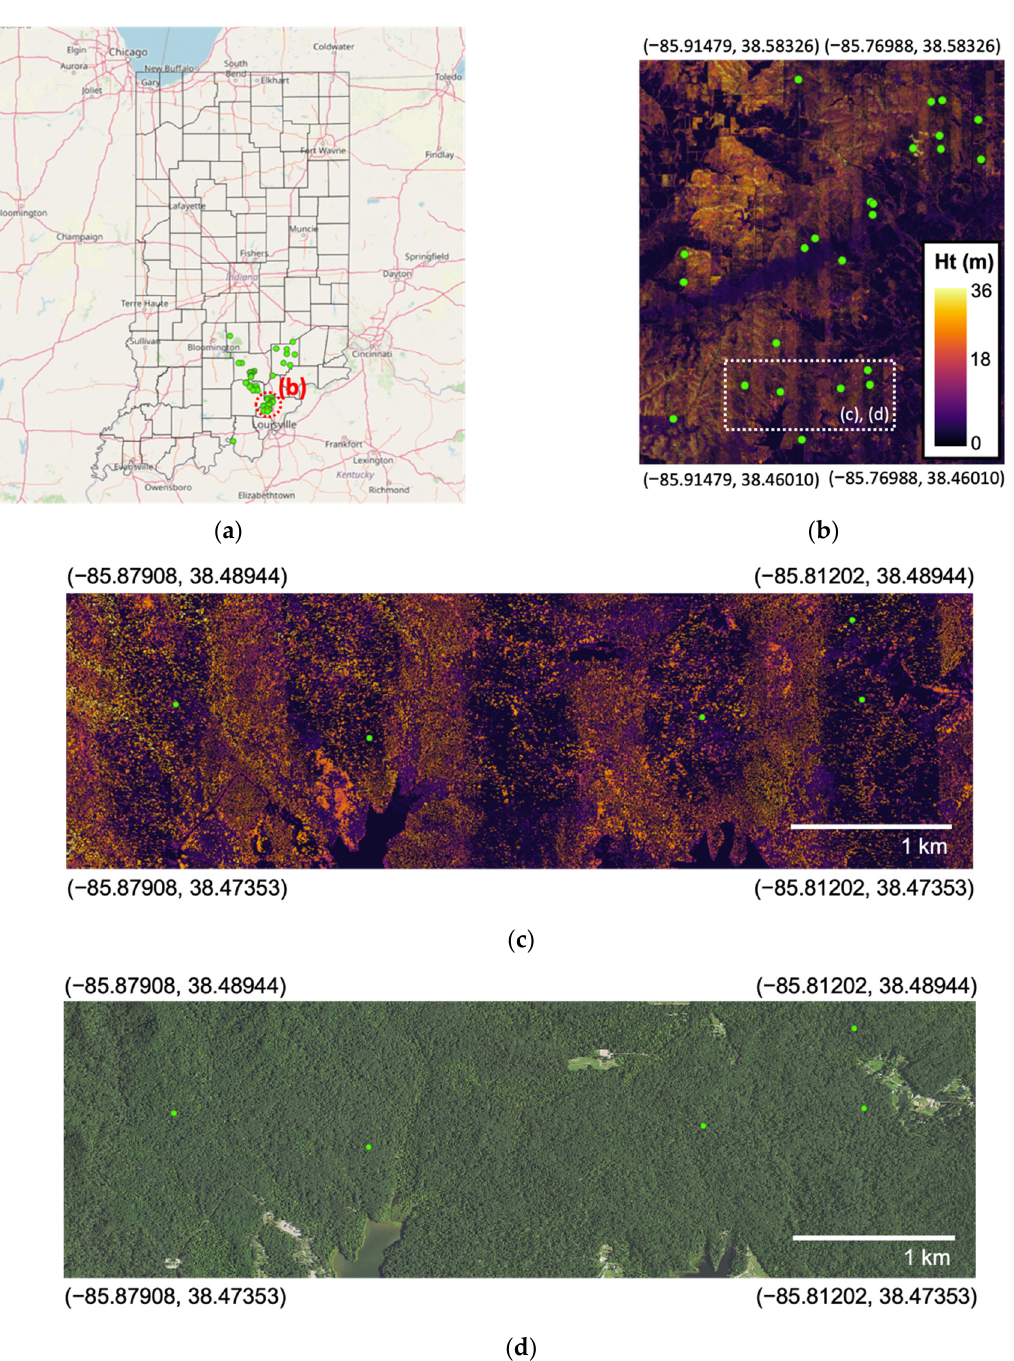
Figure 17. Inventory plots (green dots) with low height measurement accuracy: ( a ) plots with low height accuracy located in southeastern Indiana; ( b ) a subset of plots on top of canopy height model (CHM) from 2017–2020 LiDAR data, plots with low height accuracy distributed along the banded regions with a lower LiDAR point density (Figure 12); ( c ) CHM of dotted area in ( b ); ( d ) 2018 National Agriculture Image Program (NAIP) County Mosaic image of dotted area in ( b ). Ht: height. Note: a majority of inventory plots with an error less than two standard deviations were not displayed for brevity.